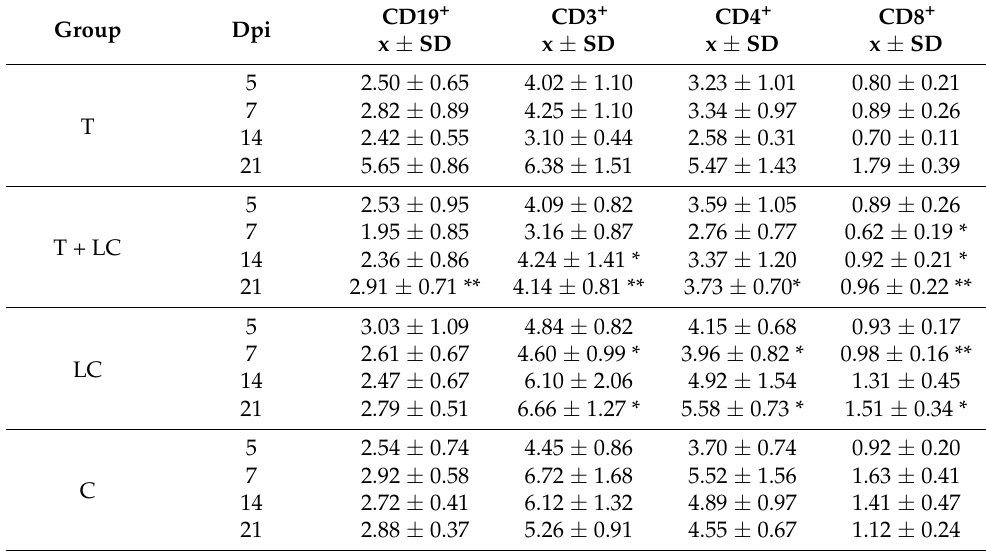
Table 6. Absolute count (cells × 10 6 ) of B (CD19 + ) and T (CD3 + , CD4 + , CD8 + ) lymphocytes in